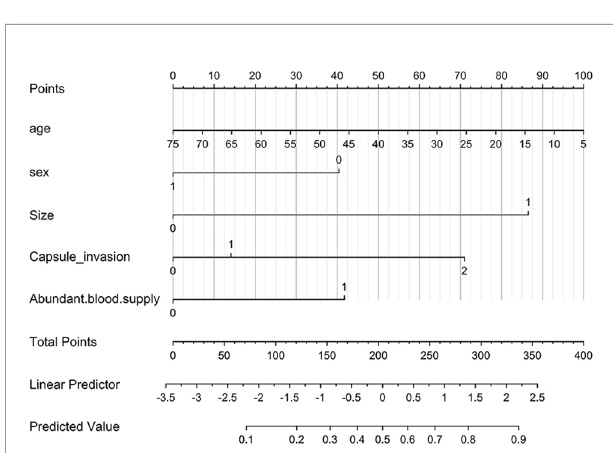
FIGURE 3 | Nomogram for predicting the risk of LN-prRLN metastasis. The linear predictor is the coordinate axis of the linear prediction value, and the linear prediction value is transformed into the corresponding probability value through a conversion